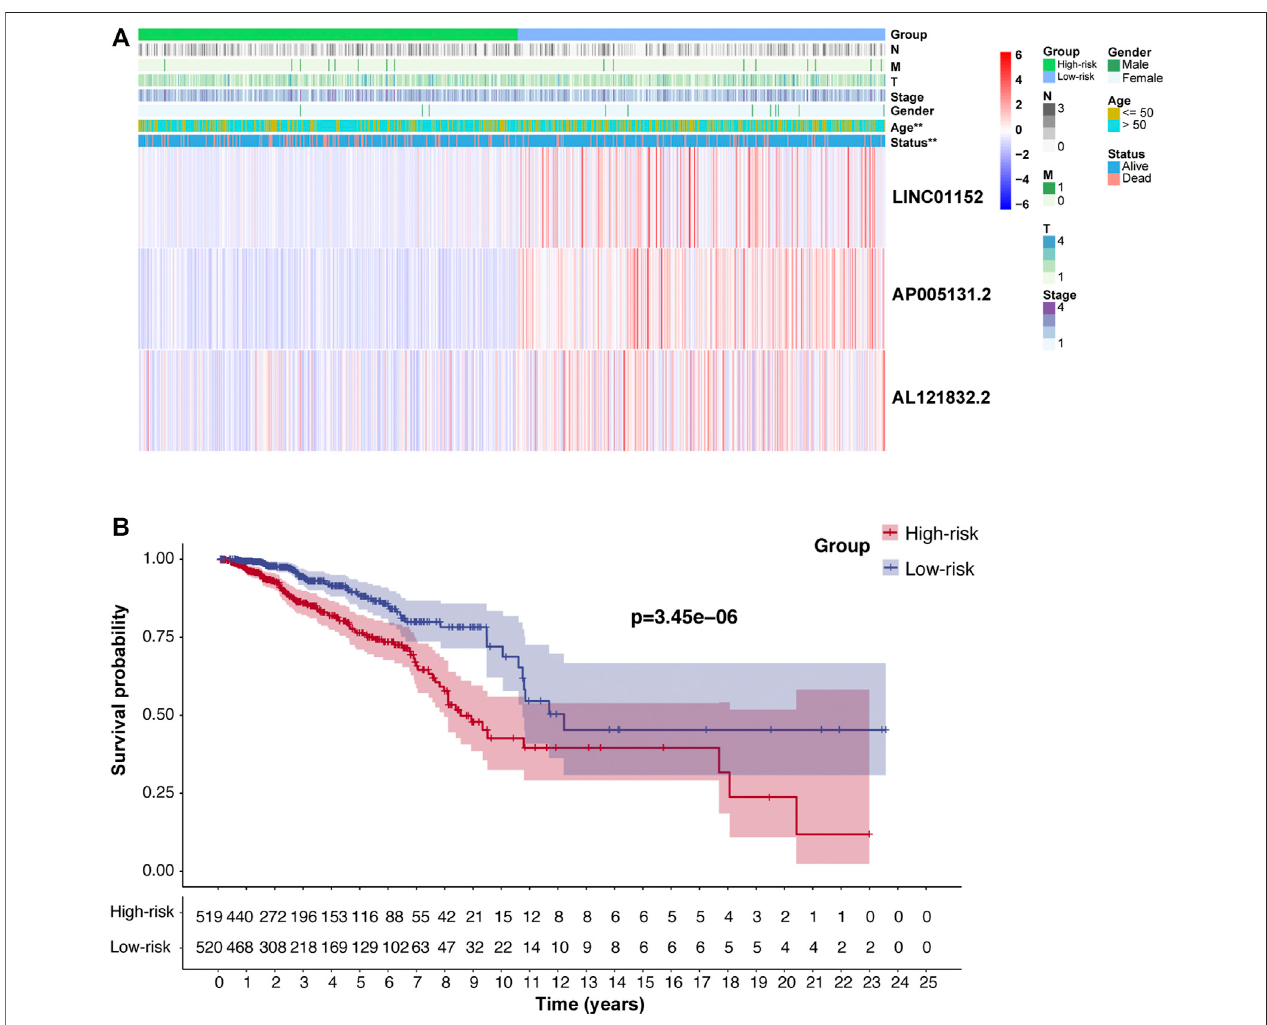
FIGURE 3 | The clinicopathological features and prognosis of patients in the high- and low-risk groups. (A) Heatmap showing the clinicopathological characteristics and expression levels of the three m5C-lncRNAs in the high- and low-risk groups. (B) Prognostic value of the model based on Kaplan – Meier survival analysis. (** p <